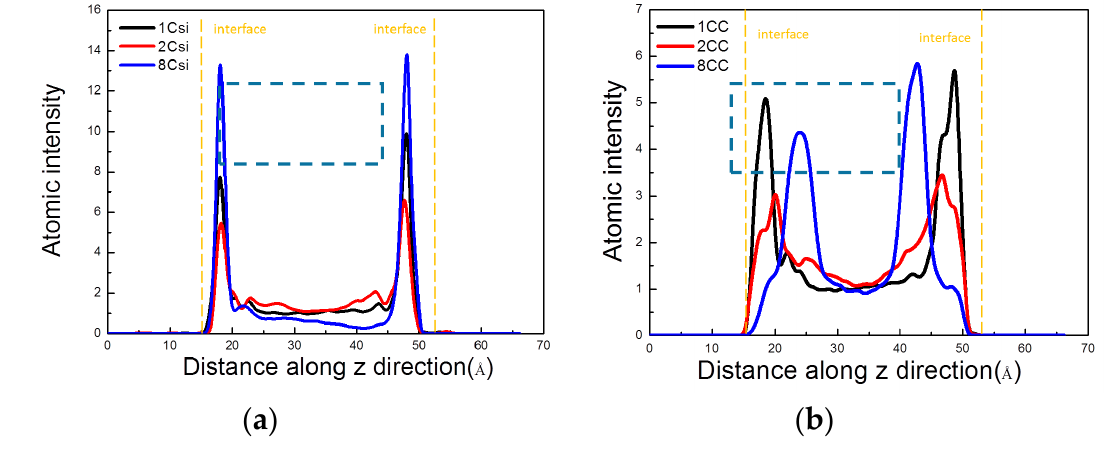
Figure 15. Atomic intensity distribution of the ( a ) Si and ( b ) C.